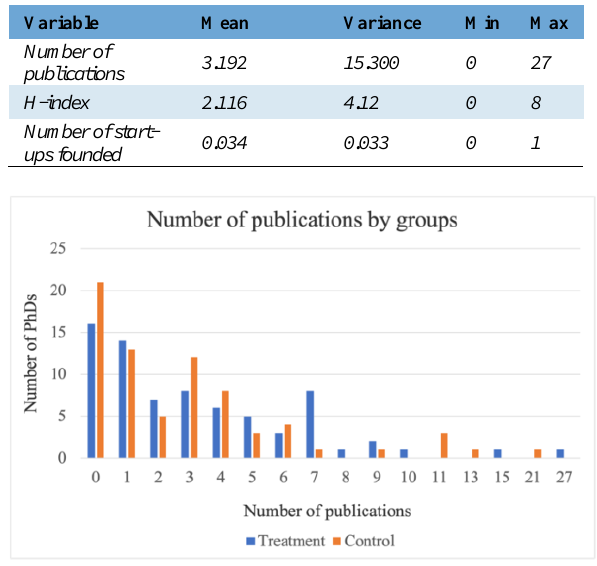
Fig. 1. Number of publications distribution for the two groups.